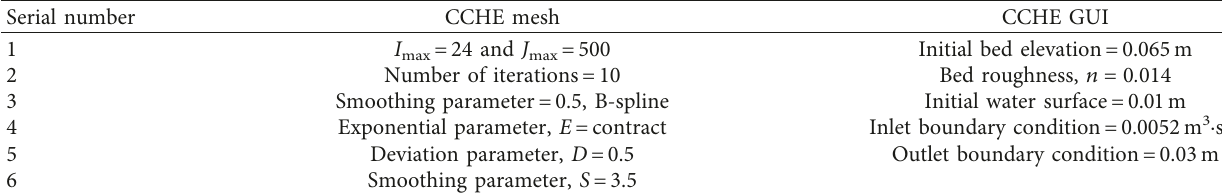
Figure 17: CCHE mesh: (a) construction of the channel boundary and (b) meshing for the entire channel. Table 1: Condition set for the numerical